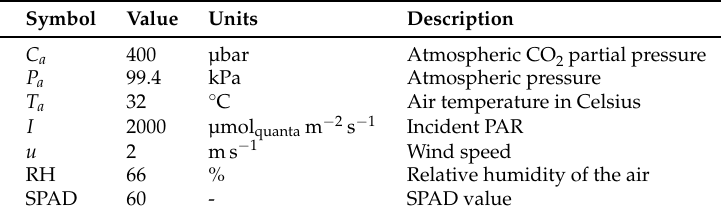
Table 1. Default values for environmental input